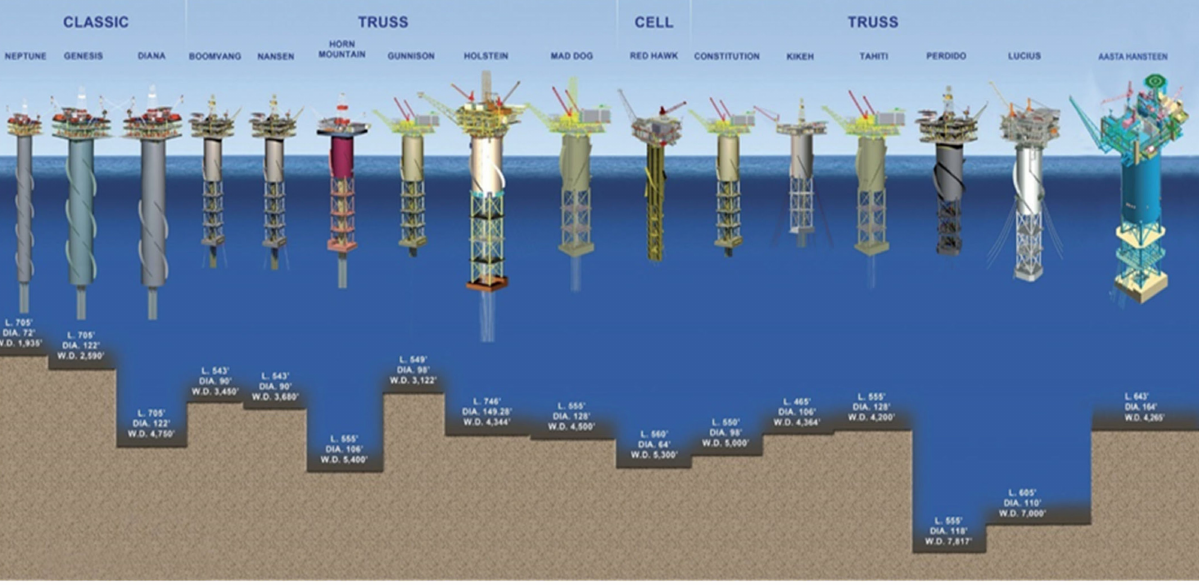
Figure A3. Historical development of SPAR platforms (Courtesy: